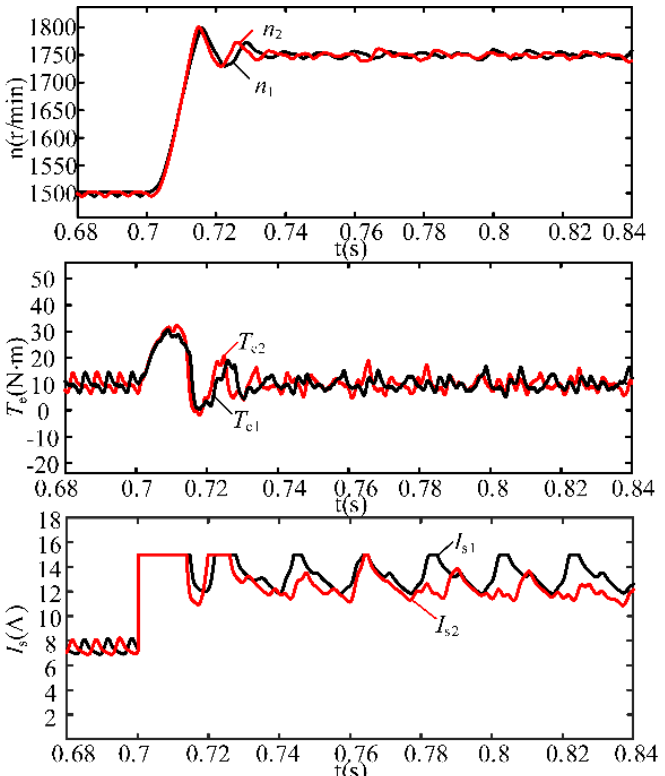
Figure 10. Simulation waveform comparison diagram of only PART_1 control and PART_1 + PART_2 control.